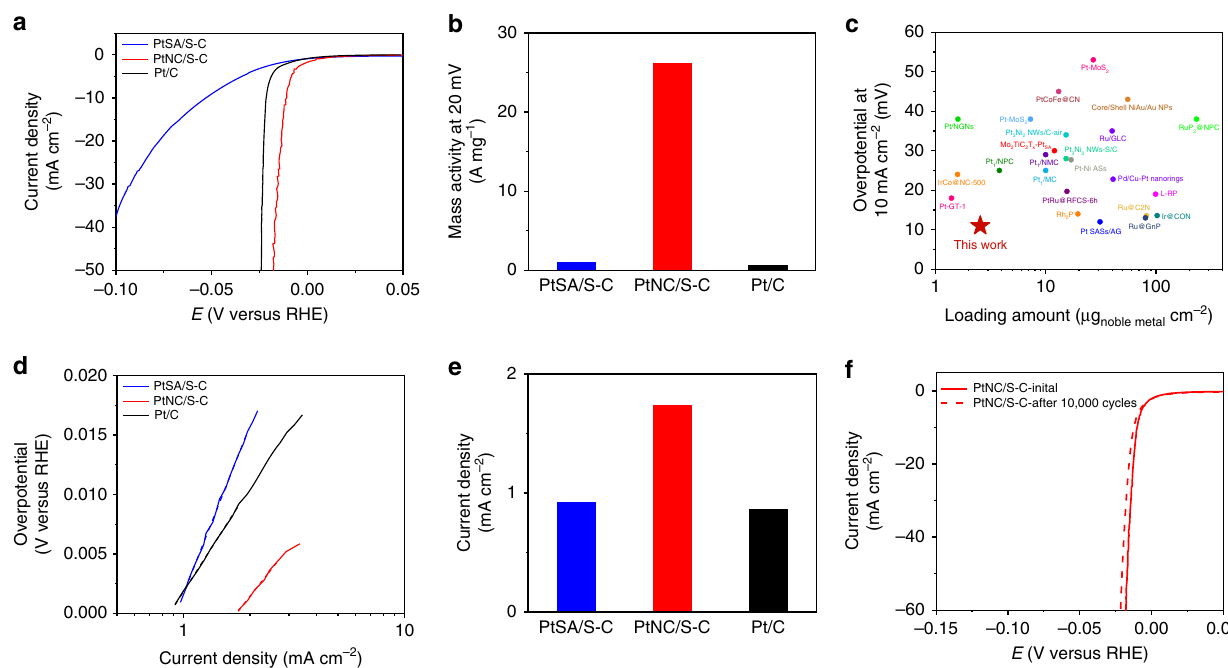
Fig. 5 Electrocatalytic performance of PtSA/S – C and PtNC/S – C. a HER polarization curves of PtSA/S – C, PtNC/S – C, and commercial Pt/C in 0.5 M H 2 SO 4 at room temperature. b Mass activity of PtSA/S – C, PtNC/S – C, and commercial Pt/C at an overpotential of 20 mV (vs. RHE). c Activity comparison of PtNC/S – C with other recently reported noble metal electrocatalysts in terms of loading amount and the overpotential at 10 mA cm − 2 (seen Supplementary Table 2 for more details for the comparison). d Tafel slope of PtSA/S – C, PtNC/S – C, and commercial Pt/C acquired from a . e Exchange current density j 0 of PtSA/S – C, PtNC/S – C, and commercial Pt/C. f Stability test of PtNC/S – C. The polarization curves were recorded initially and after 10,000 potential